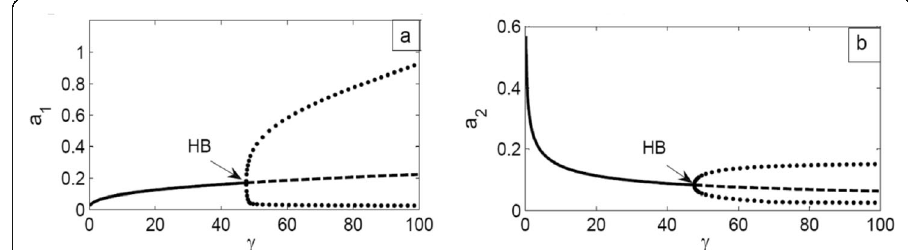
Fig. 14 Bifurcation diagram of the control signal gains γ as the bifurcation